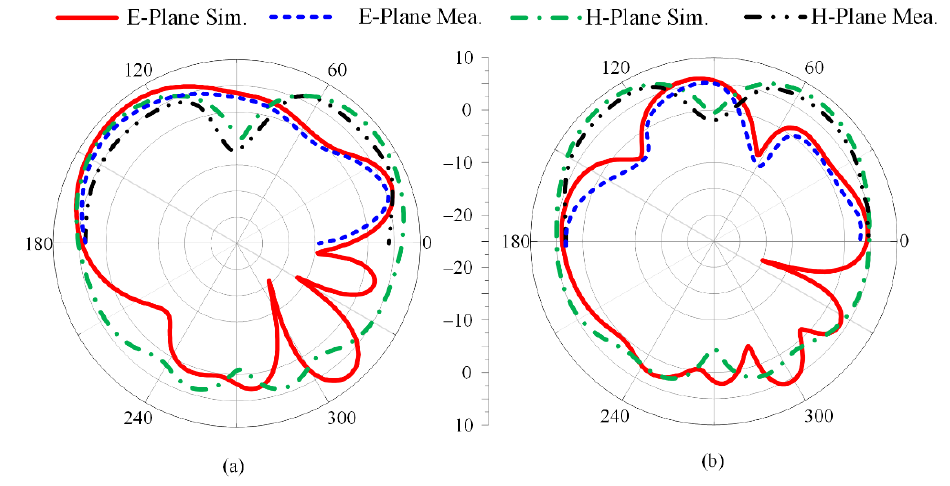
Figure 5. Measured and simulated radiation pattern of proposed dual-band antenna at ( a ) 28 GHz and ( b ) 38 GHz.